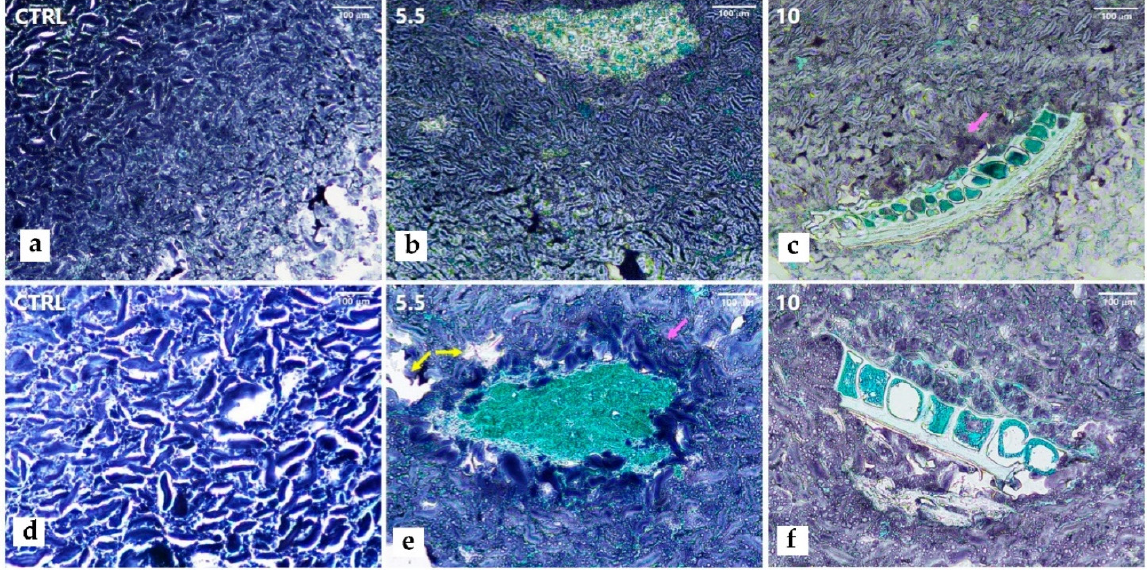
Figure 1. Light microscopy of cooked semolina pasta ( a , d —CTRL) and pasta enriched with 5.5% ( b , e ) and 10% ( c , f ) of F. vesiculosus flour, using 100× (top row) and 200× (bottom row) magnification. 3.4. Color